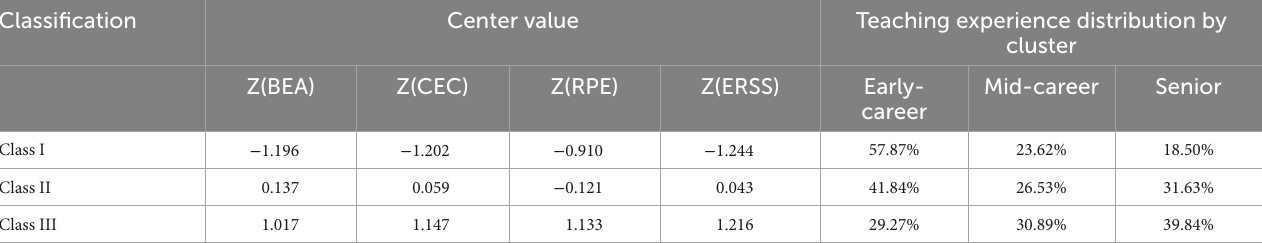
TABLE 5 Cluster-based classification of rural teachers on the basis of educational research skills and accomplishments, and the distribution across teaching experience groups within each cluster. Classification Center